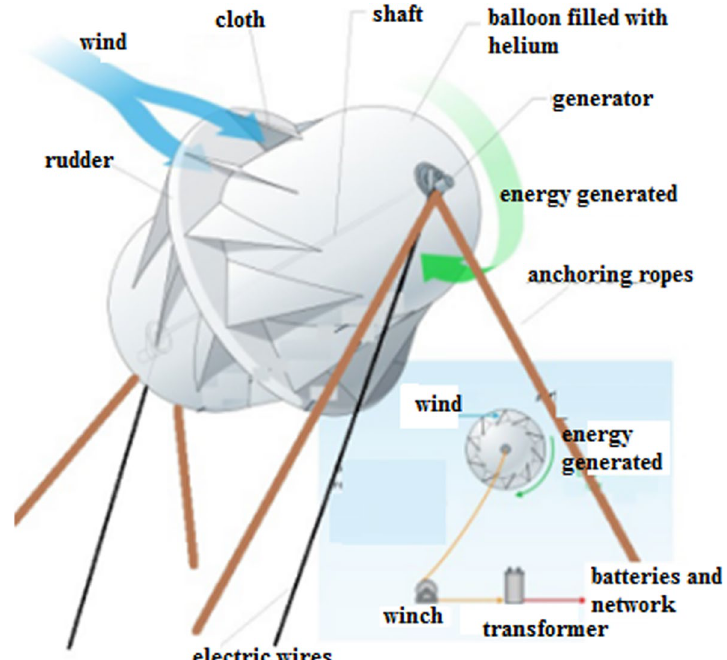
Fig. 9 FLETTNER balloon components (Vasilescu and Dinu